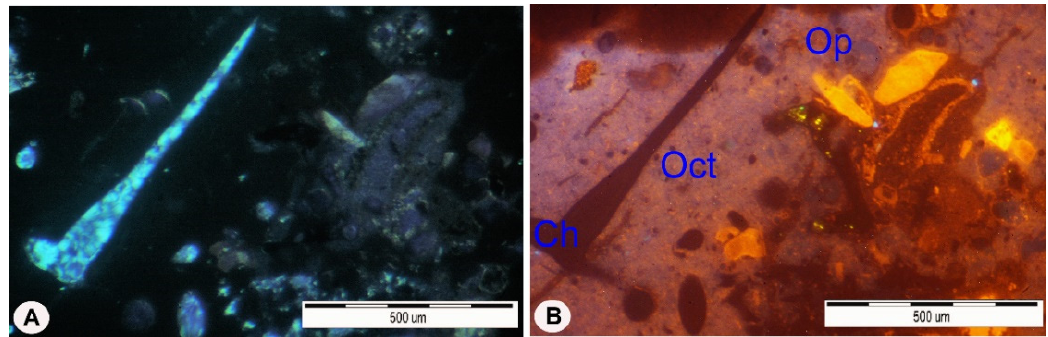
Figure 9. The opoka-rock: ( A ) Polarizing microscope, Xp; ( B ) CL image revealing an opal rocky background–pink lumi- nescence, and relics of feldspar and carbonate. Xp—crossed polarizers, CL—cathodoluminescence, Ch—microcrystalline chalcedony, Oct—opal cristobalite–tridymite, Op—Opal [67].